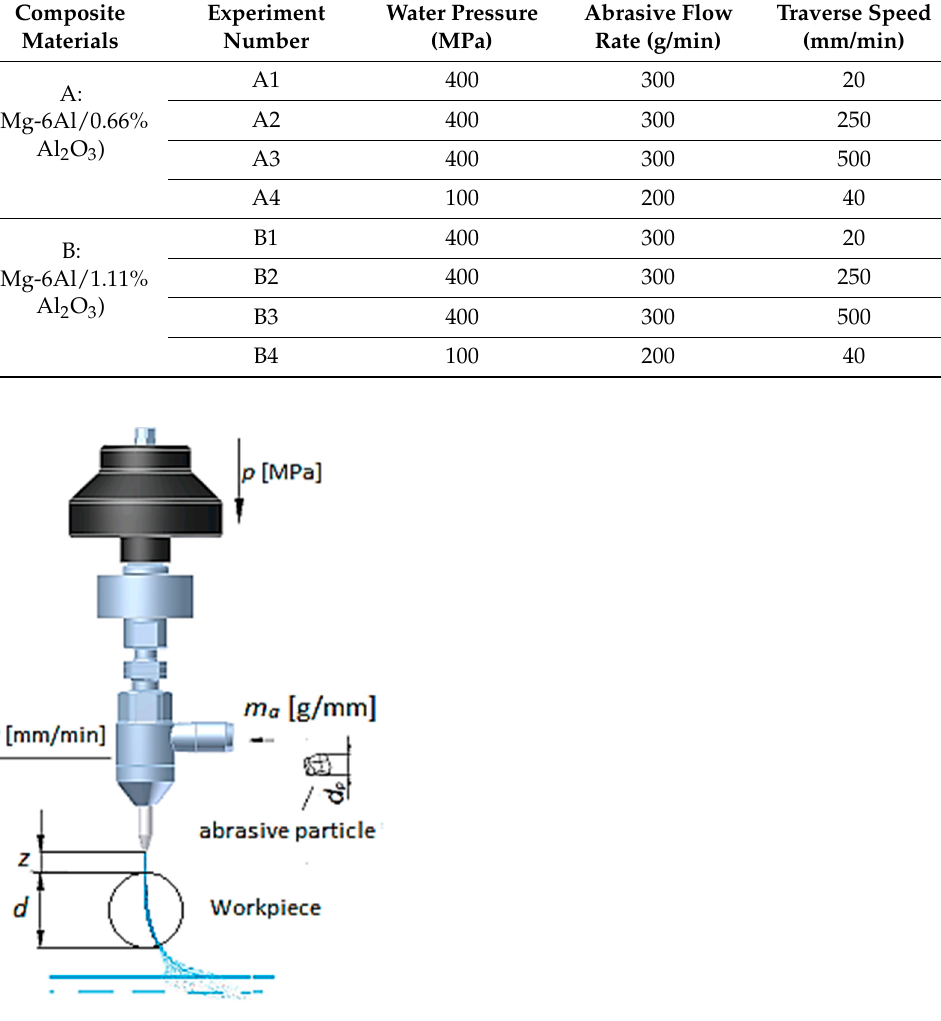
Figure 1. Diagram of cutting head with used parameters.